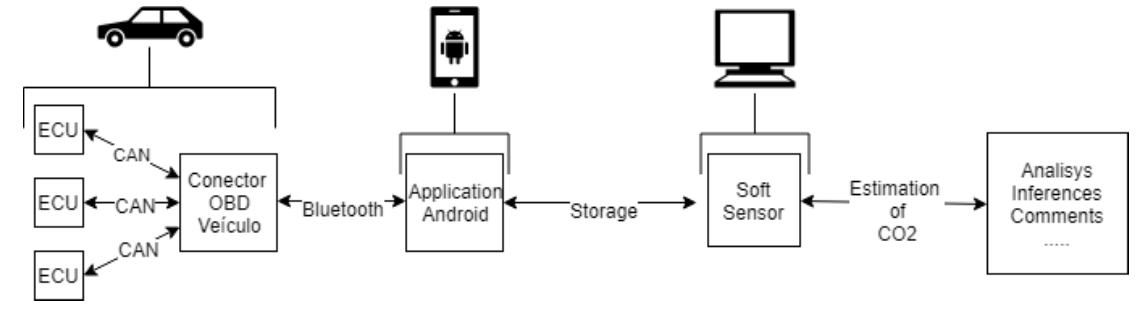
Figure 1. Architecture